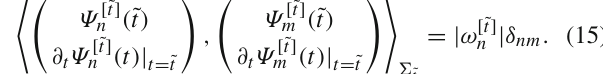
Fig. 1 Association of bases of modes { ± Φ faces (cid:6) ˜